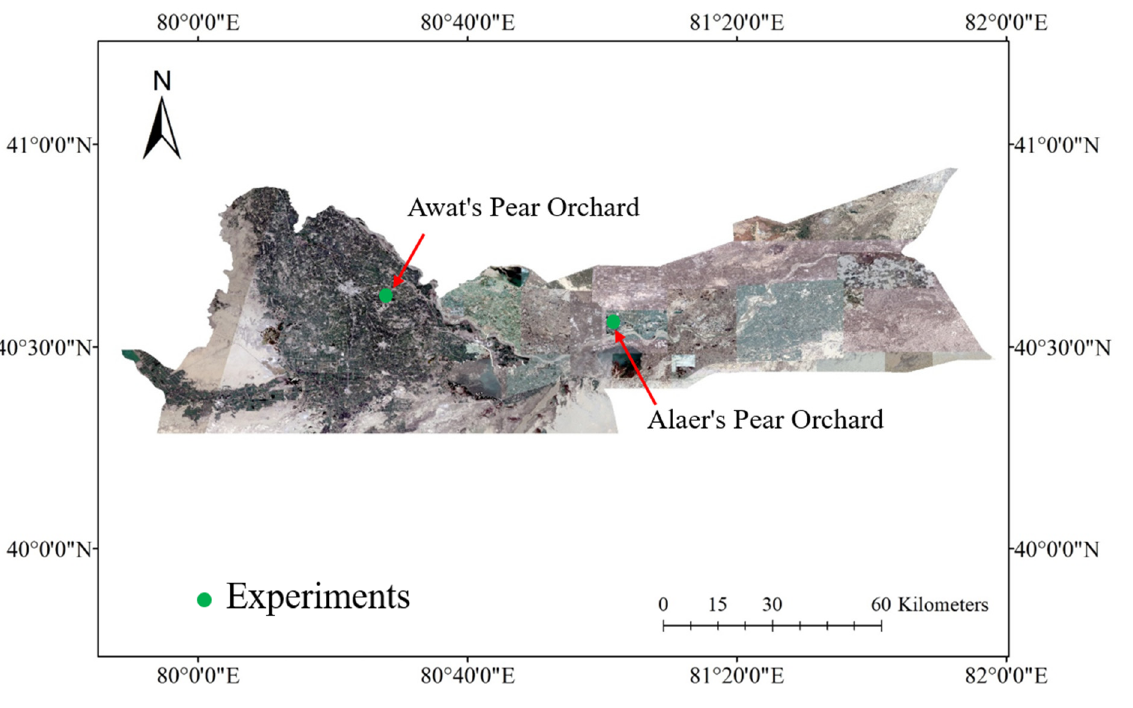
Figure 1. The location of experimental orchards in Alaer (81°01 ′ 02 ″ E, 40°33 ′ 14 ″ N) and Awat (80°28 ′ 12 ″ E, 40°35 ′ 36 ″ N), Xinjiang, China.